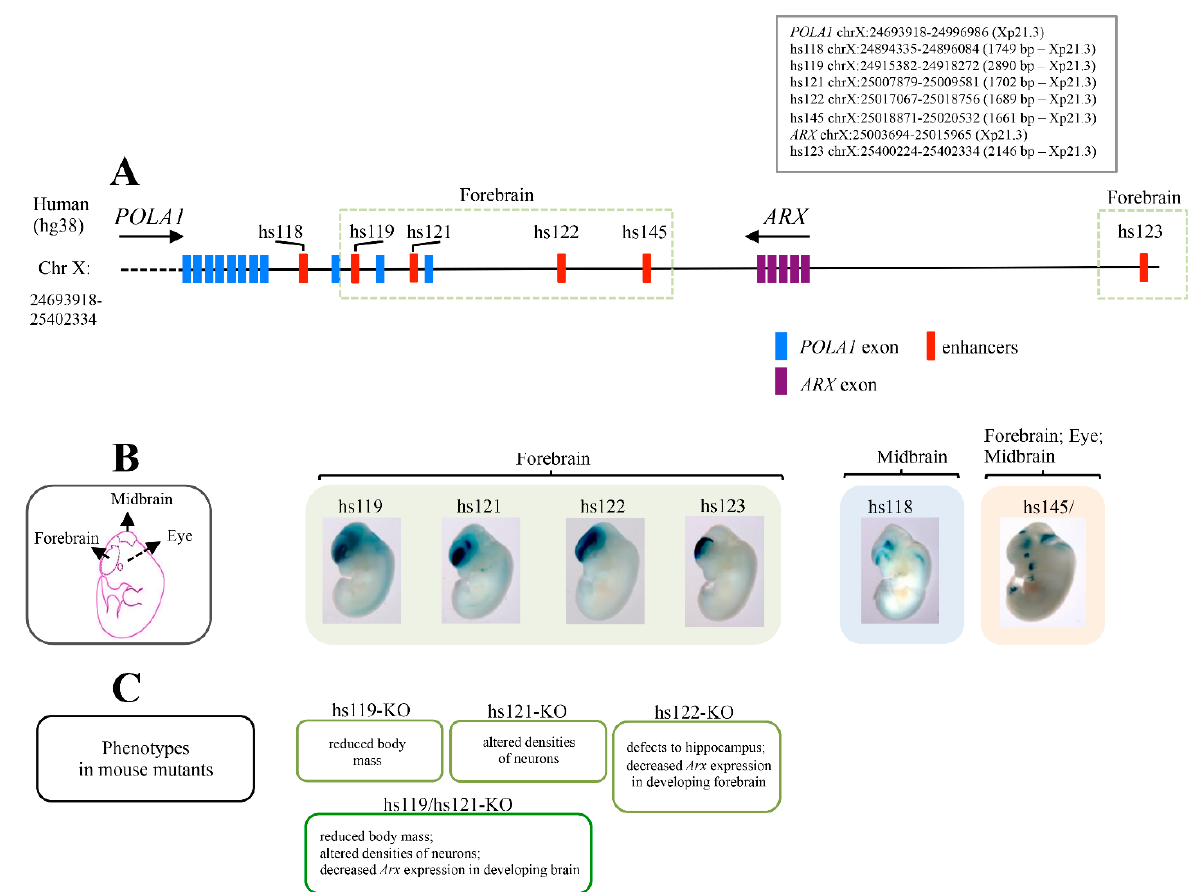
Figure 3. The ARX locus has a high density of forebrain ultraconserved sequences . Schematic representation of Xp region containing the multiple ultraconserved sequences located near the ARX locus, created on the annotation of UCSC hg38 assembly. Nucleotide positions are shown in box ( A ). Whole-mount staining images, obtained freely from VISTA Enhancer Browser (https://enhancer.lbl.gov/, accessed on 24 January 2022), showing the expression profiles of each enhancer in E11.5 embryos. Schematic representation of E11.5 brain subregions is shown in ( B ). Summary of phenotypic and molecular features of knockout mice lacking individual, or combinations of, ultraconserved Arx enhancers in shown in ( C